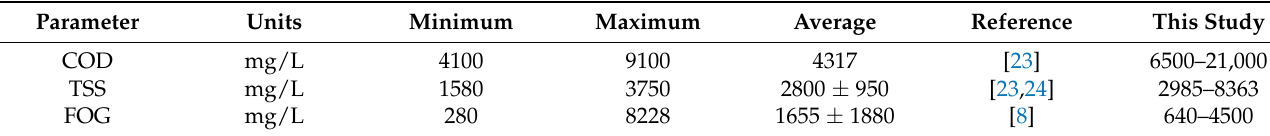
Table 3. PSW Characteristics.